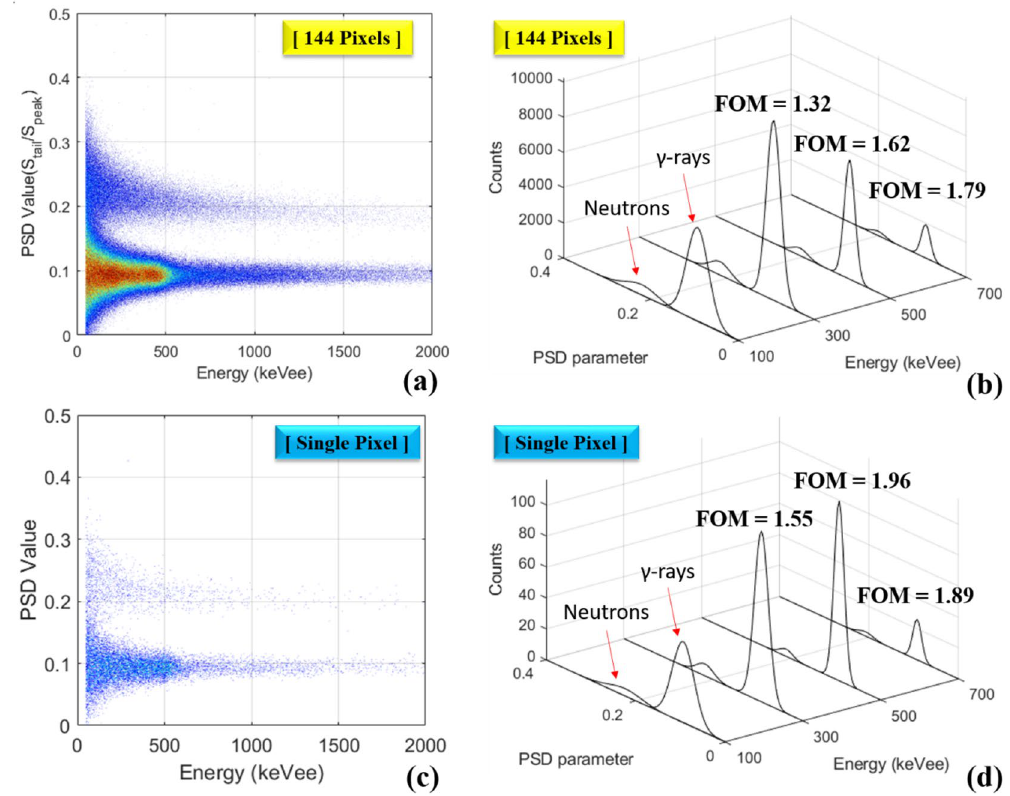
Figure 6. ( a ) The overall detector PSD plot for 1,500,000 pulses produced by the stilbene-SiPM module with a threshold of 50 keVee by measuring a 3.5 × 10 5 n/s 252 Cf spontaneous fission source at 75 cm distance and a 137 Cs source producing 30.16 μR/h at 30 cm distance. ( b ) The distribution of PSD parameter at various energies (300 ± 100 keVee, 500 ± 100 keVee, 700 ± 100 keVee) for the overall detector PSD plot. ( c ) The PSD plot that one of the pixels has and ( d ) the corresponding FOM values for the aforementioned three